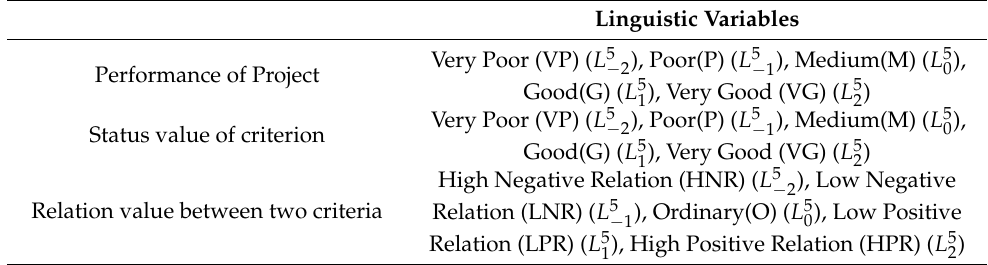
Table 2. 5 Scale linguistic variables.